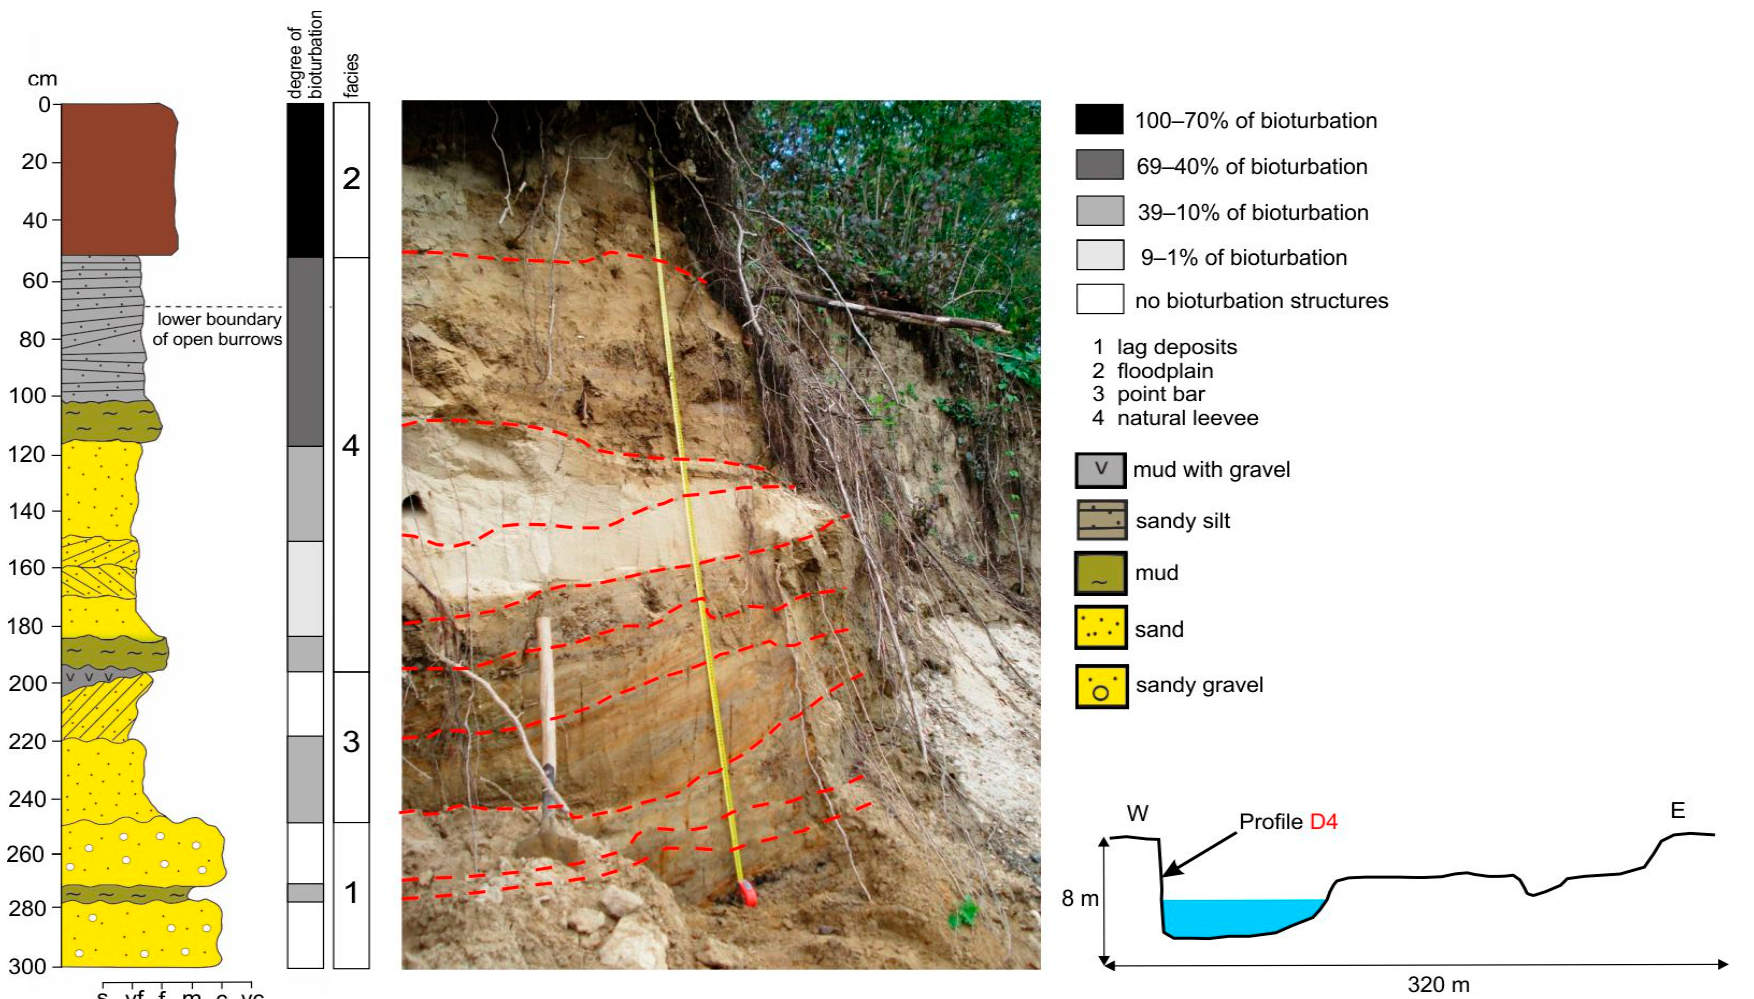
Figure 6. Characteristic of the vertical profile D4 in the Dunajec River—sediment features and degree of recent bioturbation.